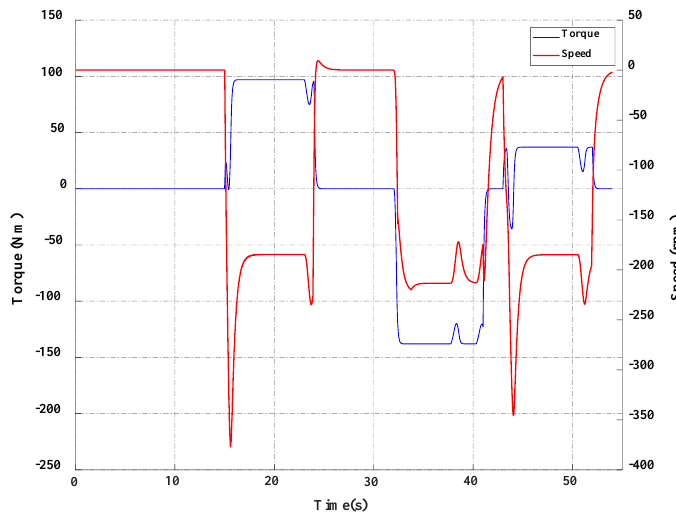
Figure 12. Pressure and flow rate of the boom cylinder.